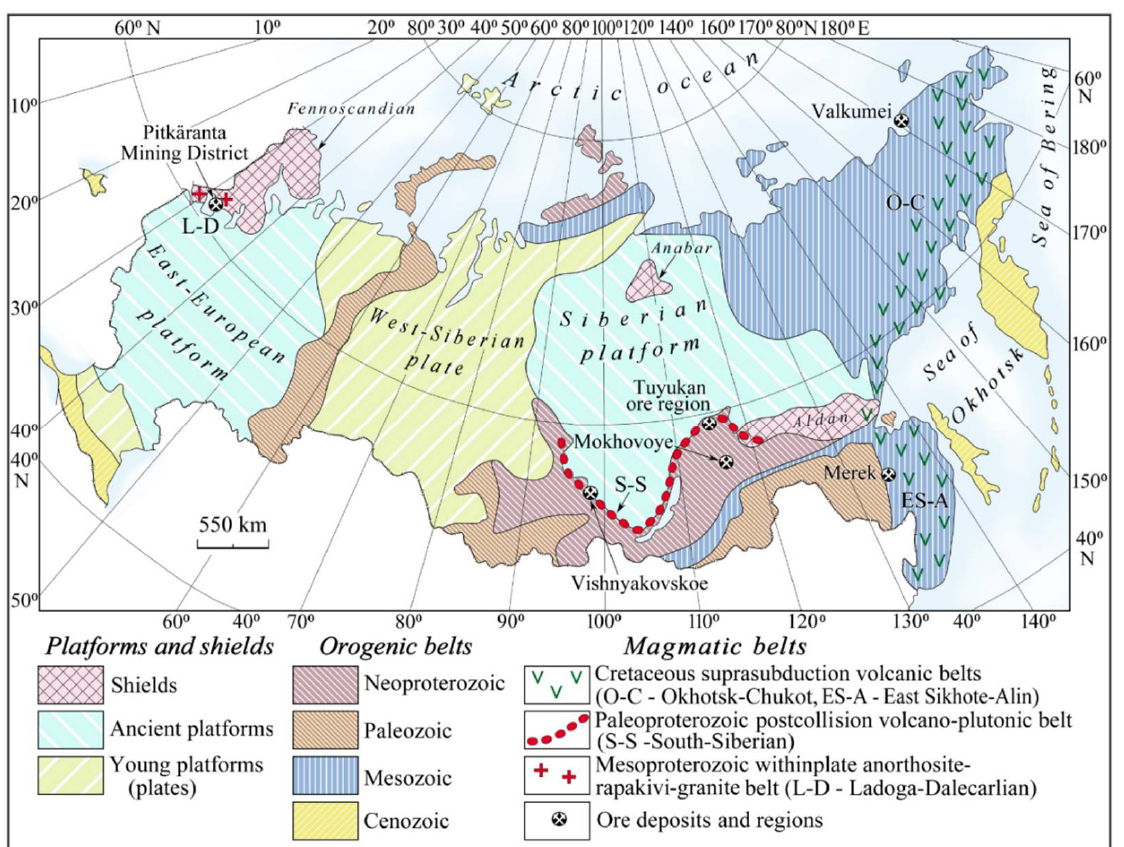
Figure 1. Simplified tectonic map of Russia showing locations of studied ore deposits. Modified from [37].